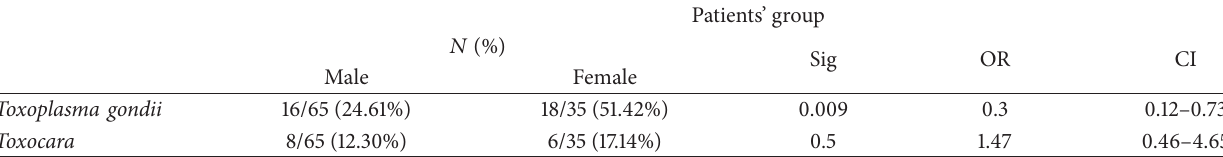
Table 5: The seroprevalence of anti- T. gondii IgG antibodies in patients with schizophrenia disorder based on gender.